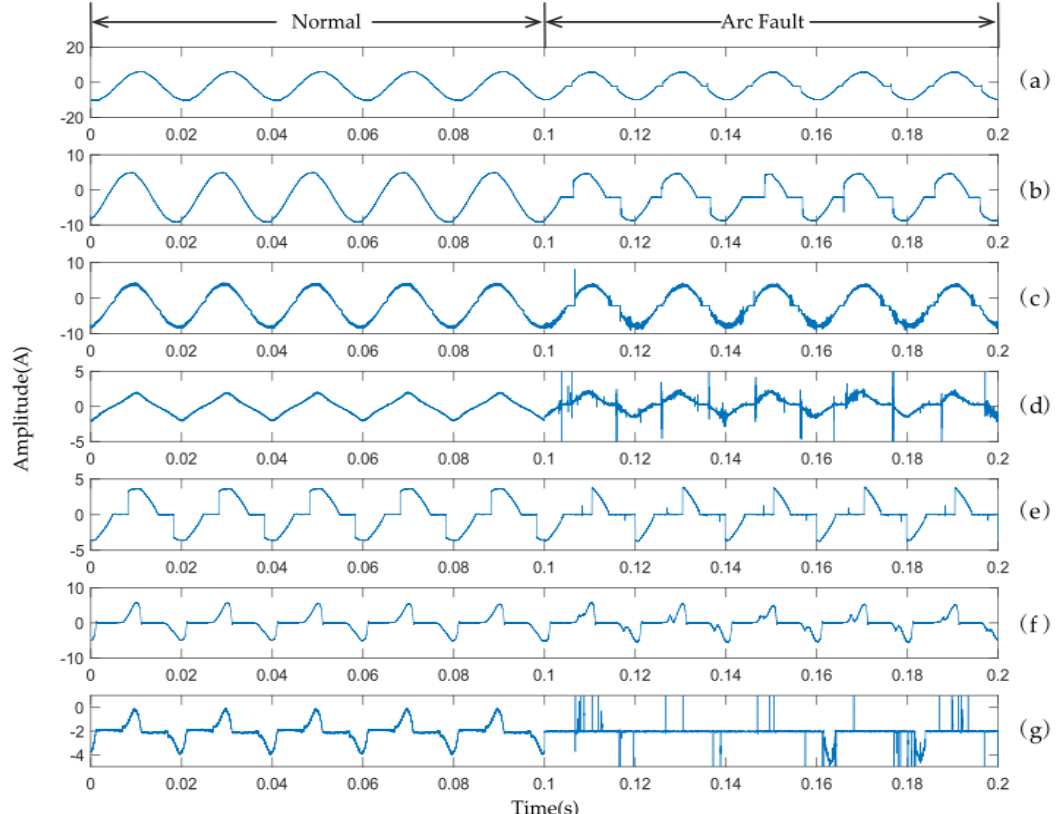
Figure 15. Load current waveforms. ( a ) Pure resistance. ( b ) Fluorescent lamp. ( c ) Halogen lamp. ( d ) Electric drill. ( e ) Tungsten filament lamp. ( f ) Air conditioner. ( g ) Computer host. Table 5. Experimental loads and their categories.